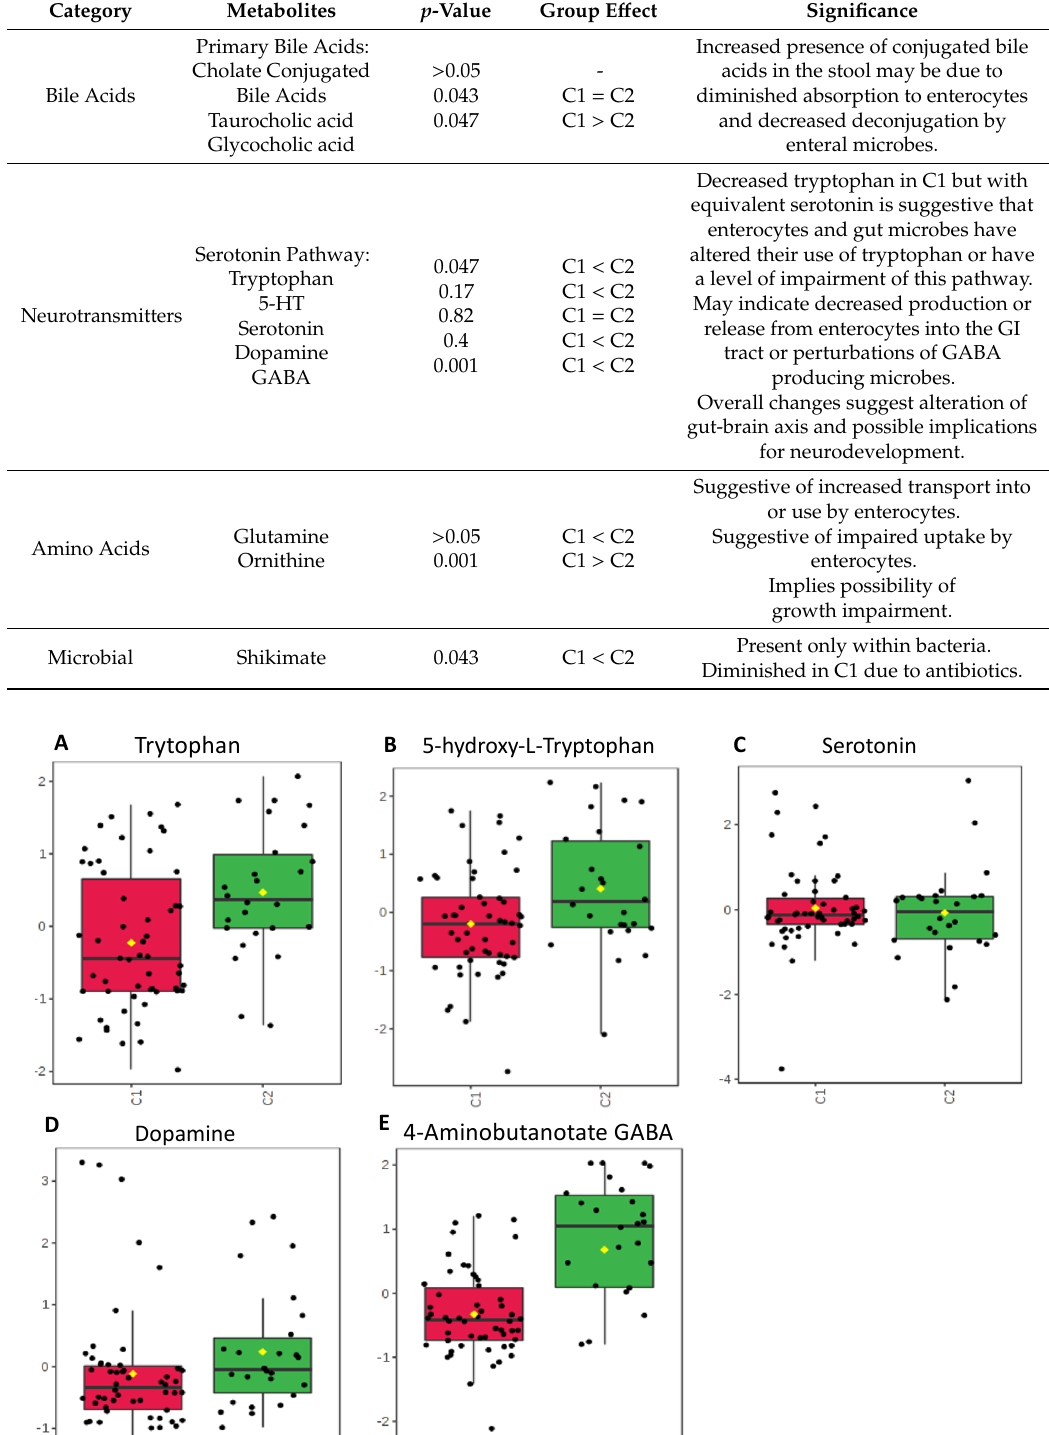
Figure 6. Amino Acids. Fecal concentrations compared between groups C1 and C2. ( A ) Glutamine, with a trend of decreased concentration in the group exposed to antibiotics ( p > 0.05). ( B ) Ornithine, with increased concentration in the group exposed to antibiotics ( p = 0.001).